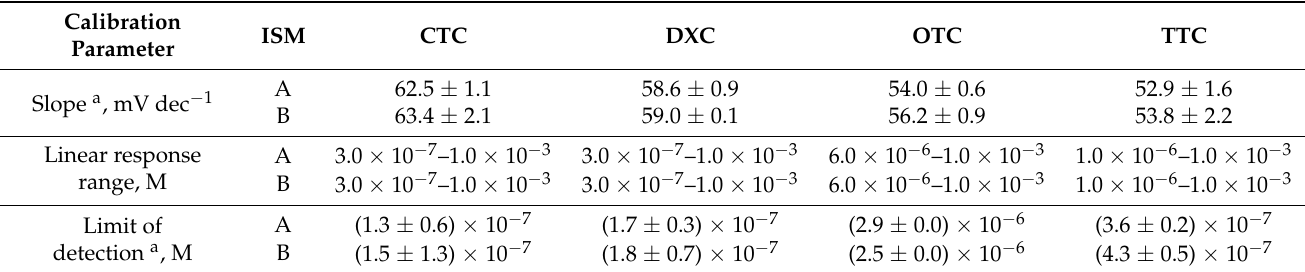
Table 2. Calibration parameters of the conventionally shaped electrodes prepared without (ISM A) and with ionophore (ISM B) in batch mode for different tetracycline